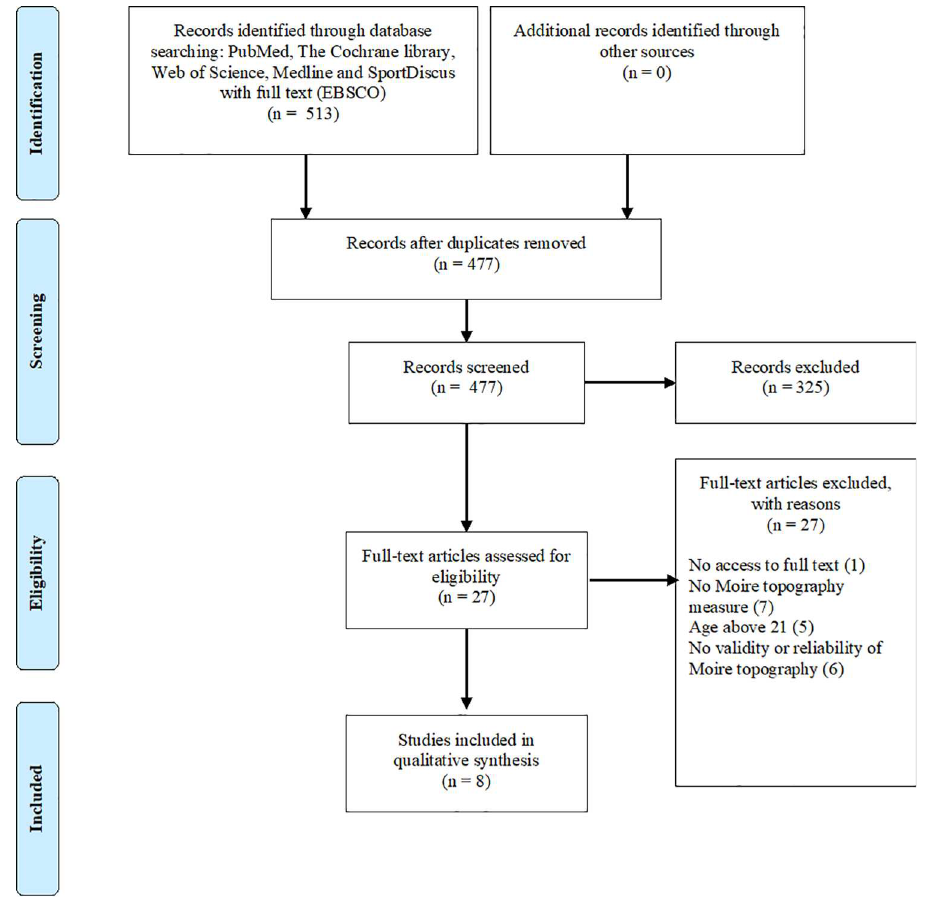
Fig 1. Flow chart of the included studies in this review.